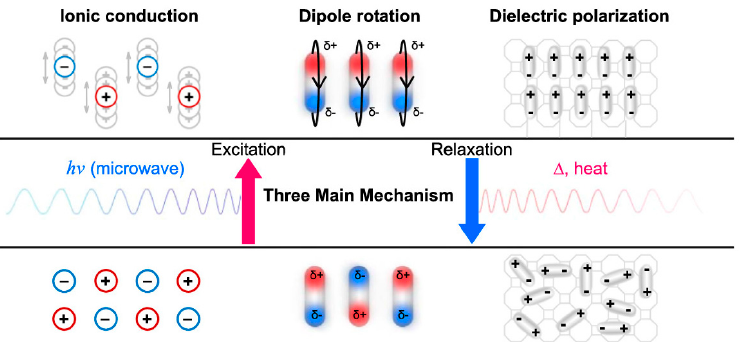
Figure 2. The mechanisms of the interaction of MW with the MOF. Reprinted (adapted) with permission from [75]. Copyright 2019, American Chemical Society.